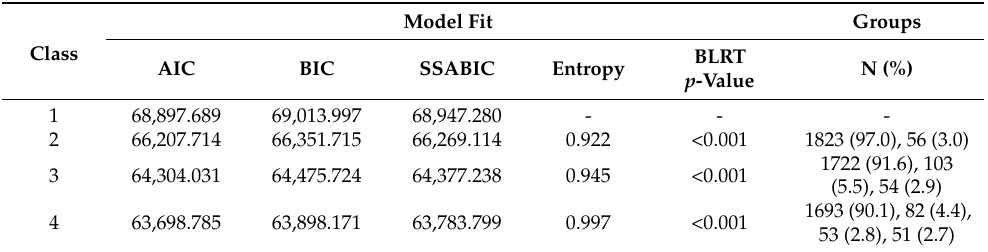
Table 3. Goodness of Fit for GMM ( n =